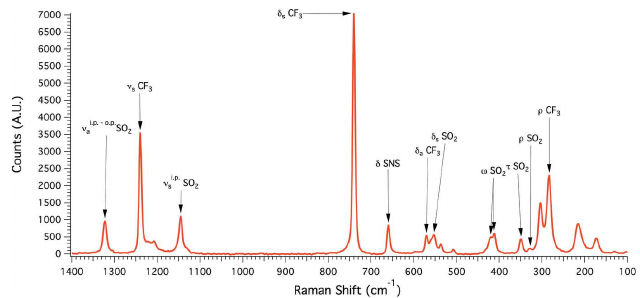
Figure 3 Raman spectra of Cs[Tf 2 N] with no other bands observed from 1400 cm (cid:3) 1 to 3200 cm (cid:3) 1 . The additional bands at 535 and 507 cm (cid:3) 1 suggest the multiple SO 2 bending modes associated with multiple coordination modes. Major band assignments are given with (cid:3) (stretching), (cid:4) (bending), ! (wagging), (cid:5) (twisting) and (cid:6) (rocking) followed by the functional group. Planar designations are i.p.for in plane and o.p. for out of